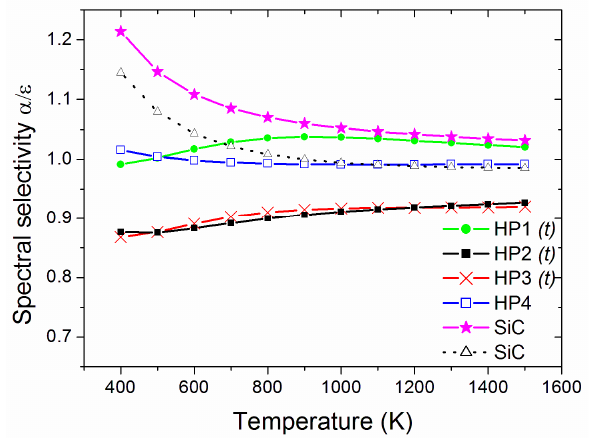
Figure 6. Estimated thermal emittance as a function of temperature. The label (t) identifies the samples showing transparency (non-null transmittance) at the considered thicknesses.